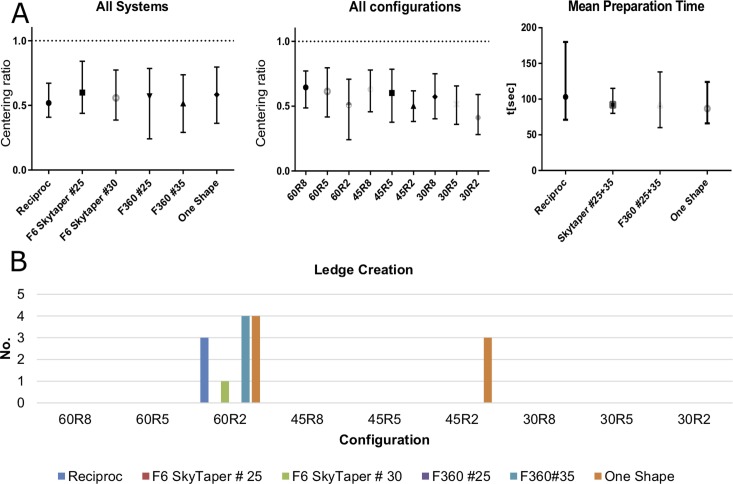
A Left: Error bar plots (symbol: mean value; whiskers: minimum and maximum value) of centering ratios for the different instrument systems used (calculations aggregated for all canal configurations). Middle: Error bar plots of centering ratios (calculations aggregated for all preparation systems). Right: Error bar plots of preparation times for the different preparation instruments. B Number of ledges created per canal configuration by the different preparation instruments.